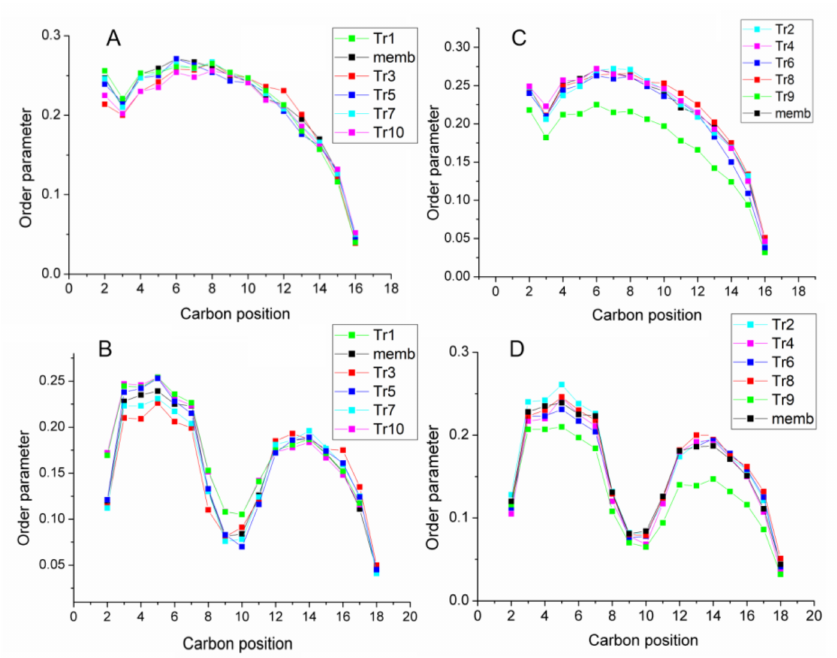
Figure 6. Profile of the uperin effects on the order parameters S CH of POPG lipids for chains sn1 ( A ), sn2 ( B ) of wild-type uperin and for chains sn1 ( C ), sn2 ( D ) of mutant peptide. For comparison, profiles for membrane without peptides are shown in